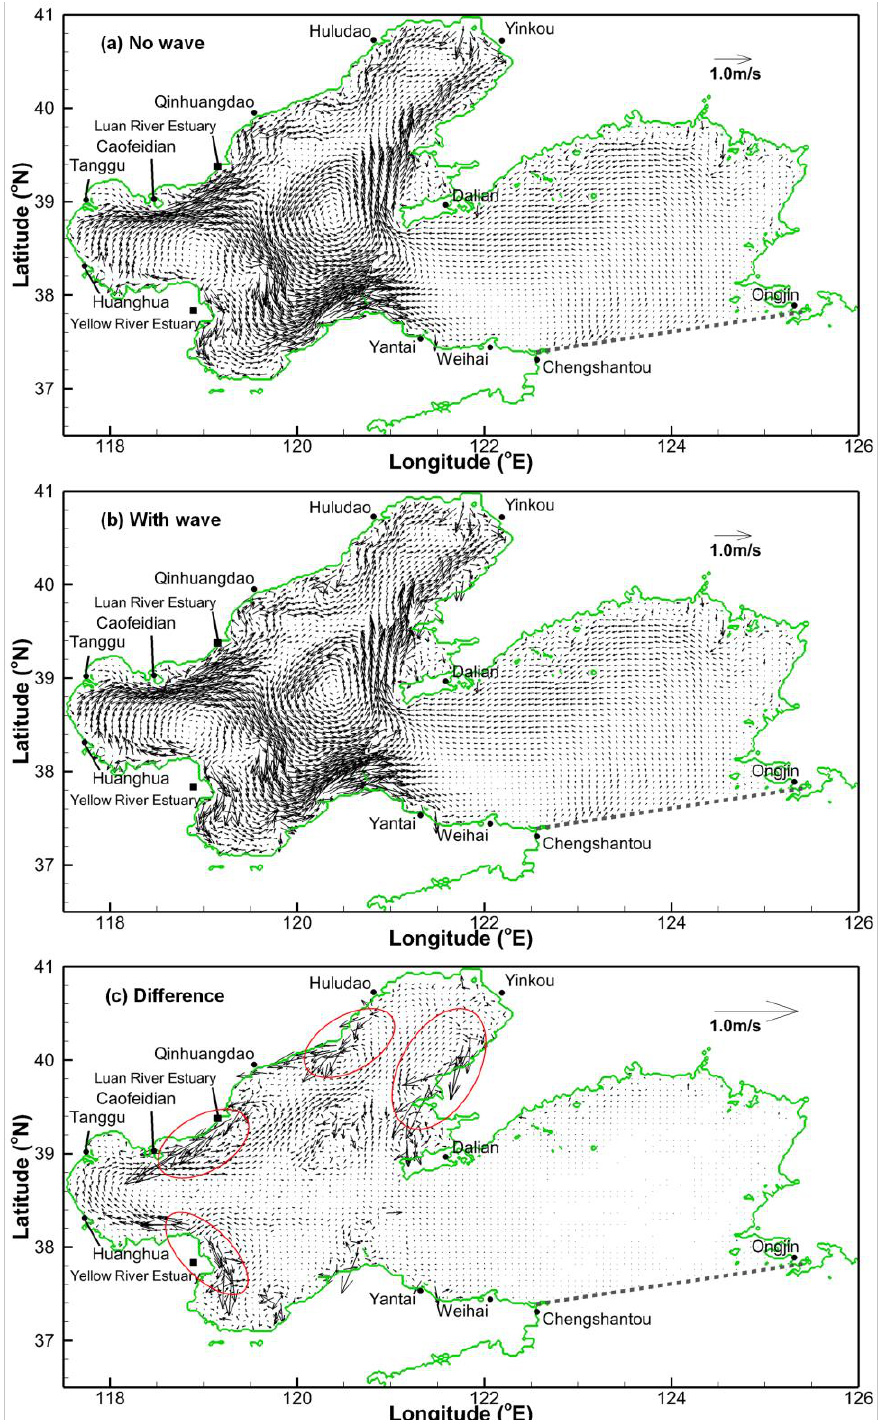
Figure 7. Wave effect on currents (at the time step for which the surge in the south Bohai Sea peaks). ( a ) Currents without waves (run 6). ( b ) Currents with waves (run 4). ( c ) Difference between currents with and without waves. The red circles in ( c ) indicate regions with strong longshore currents. The main differences between the two runs appear in onshore regions, especially near the Yellow River estuary, the Luan River estuary, and the west and east coasts of the Liaodong Bay. In these regions, the longshore currents could explain the differences. Indeed, under north wind conditions, the longshore currents in the Liaodong Bay and near the Luan River estuary are almost southward. The longshore currents transport water to the regions that suffer from severe surges,